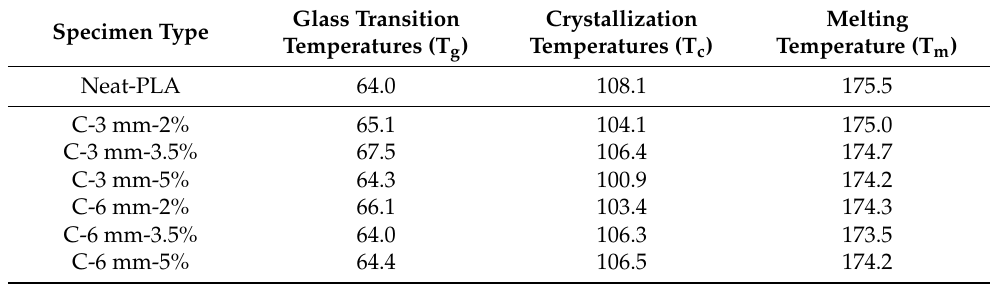
Table 6. DSC analysis